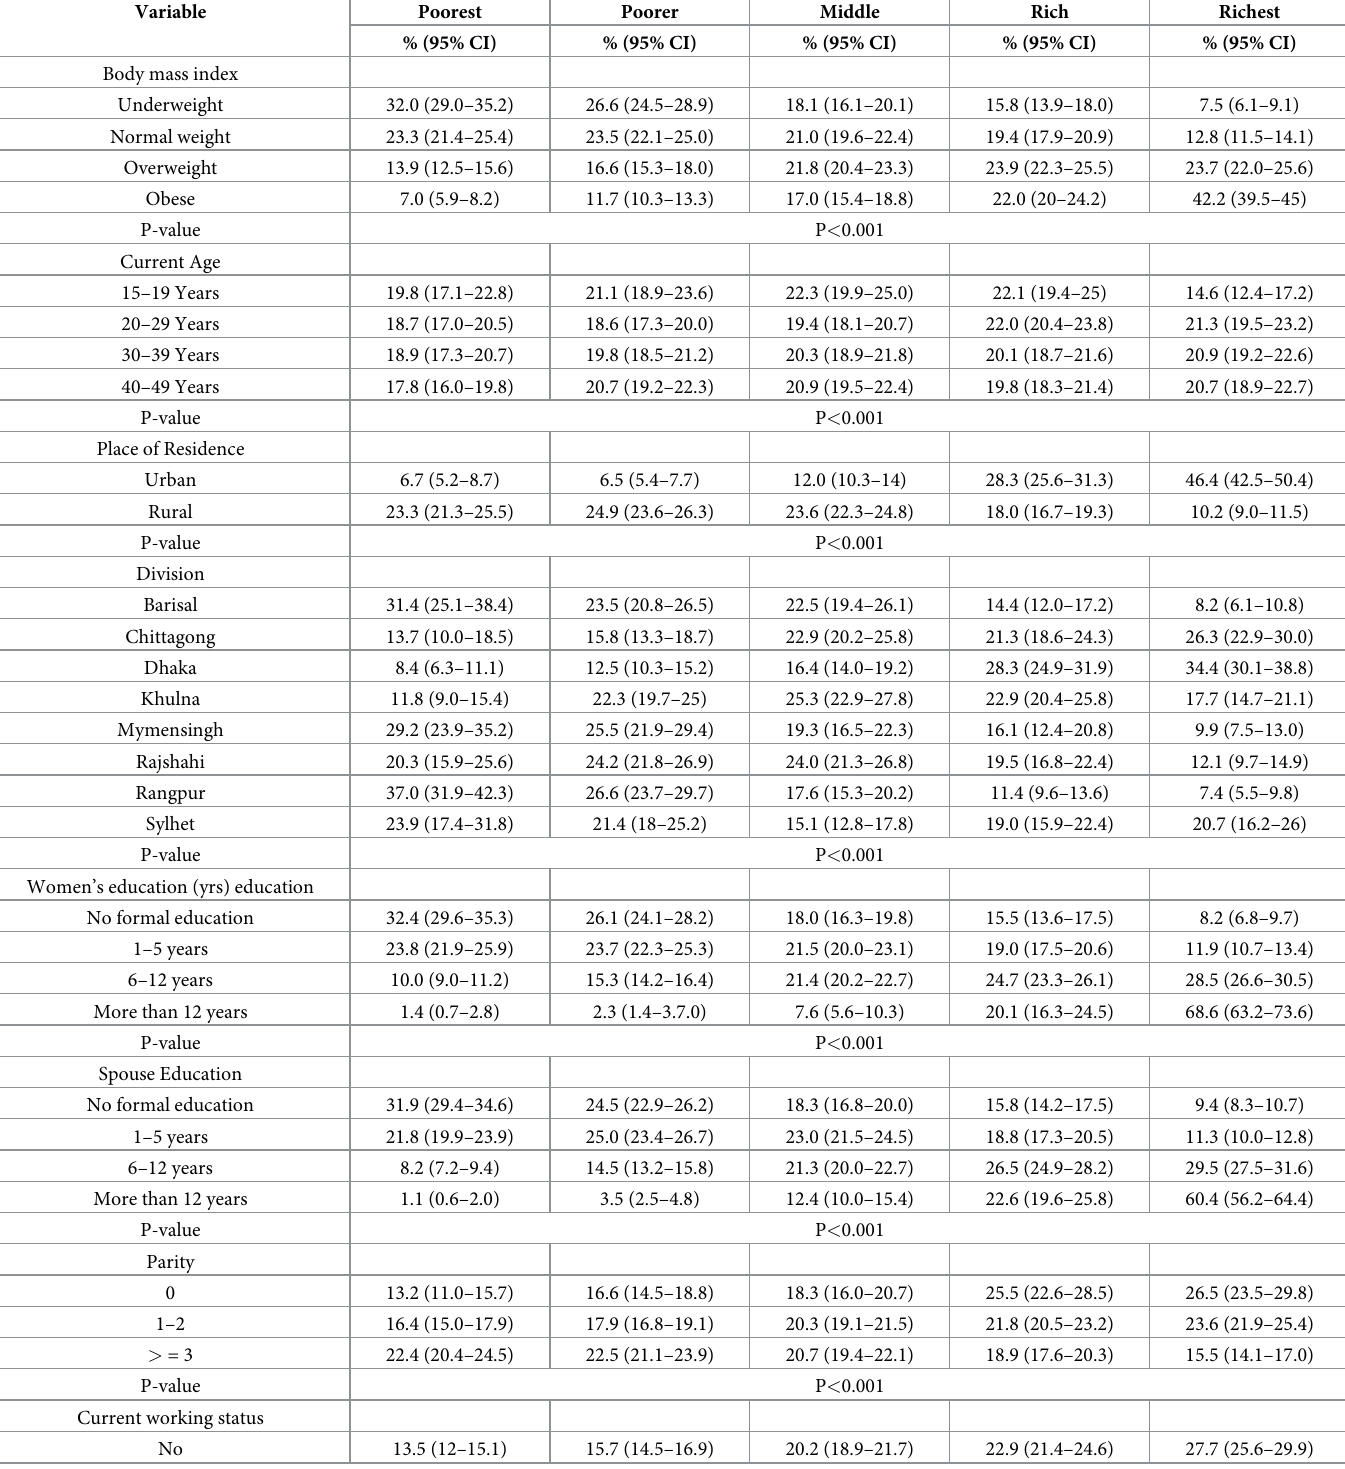
Table 2. Percentages of wealth index categories by various socio-demographic variables and their bi-variate associations among the reproductive aged women of BDHS 2017–18.